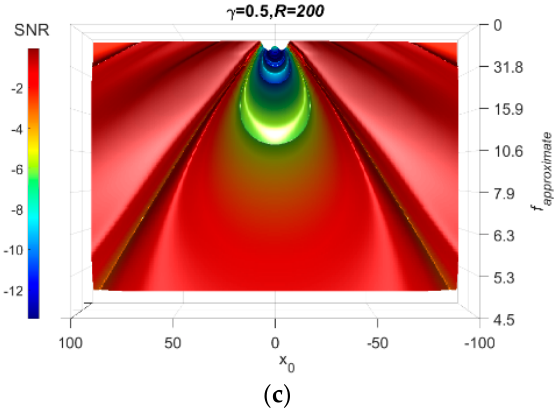
Figure 8. Influence of the scaling factor on the FI-UPRS method. ( a ) R = 1 ( b ) R = 50 ( c ) R = 200.